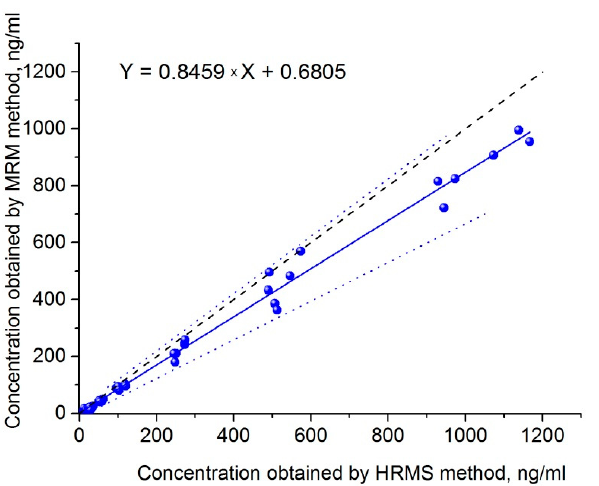
Figure 4. The Passing–Bablok correlation plot. The correlation between ST-246 concentrations in plasma (blue dots), as determined by the validated PRM method (x-axis) and MRM method (y-axis). Solid blue line, regression line; dashed bold line, identity line; dot blue line, confidence interval for the regression line.